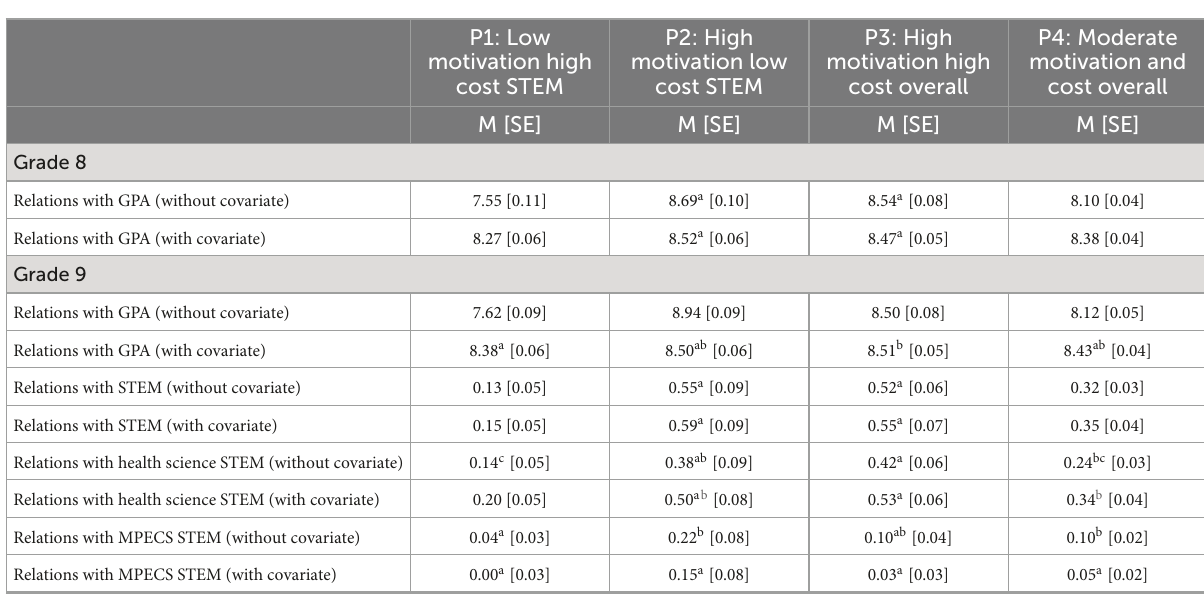
TABLE 6 Task value-profiles and academic achievement and STEM